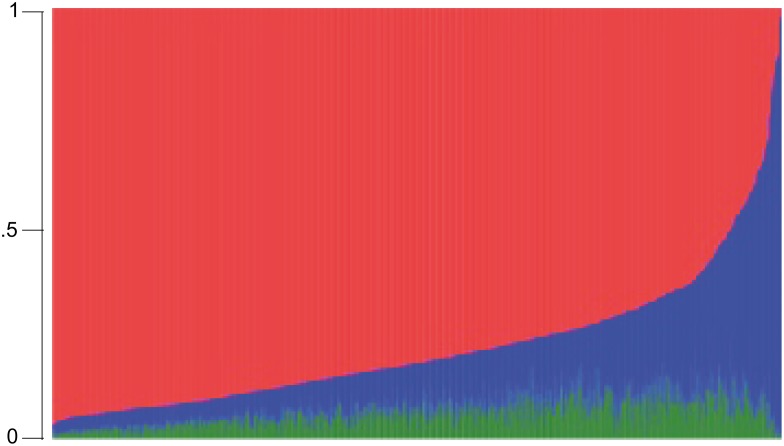
Tri-Hybrid Genome-Wide Individual Proportion of Ancestry (n = 1,311), Bambui Cohort Study of Ageing.The red, blue and green colors represent the European, African and Native American ancestry proportions, respectively.